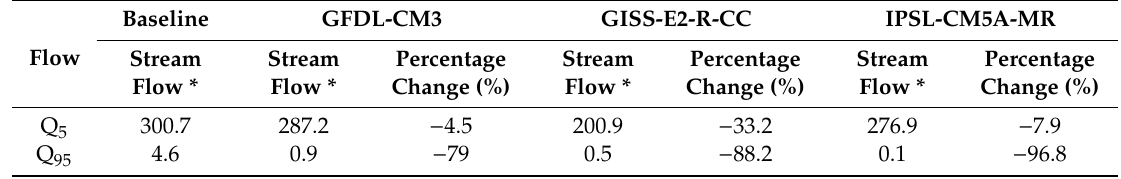
Table 7. Percentage changes in Q 5 and Q 95 during the future time periods.